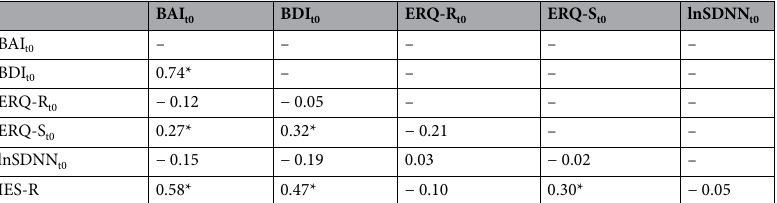
Table 2. Pearson’s correlations among study variables. BAI Beck Anxiety Inventory, BDI-II Beck Depression Inventory, ERQ-R Emotion Regulation Questionnaire-Reappraisal scale, ERQ-S Emotion Regulation Questionnaire-Expressive Suppression scale, lnSDNN natural logarithm of standard deviations of N–N intervals. All variables were scaled and centered, and p -values were FDR Benjamini–Hochberg Adjusted. * p <